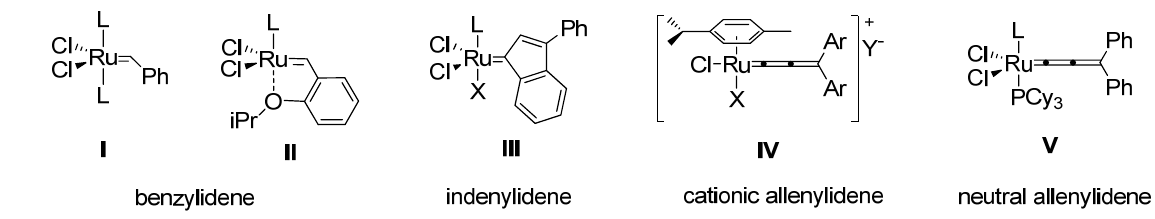
Figure 1. Selected examples of Ru-based olefin metathesis precatalysts; L: phosphine, NHC; X: halide; Y: counter